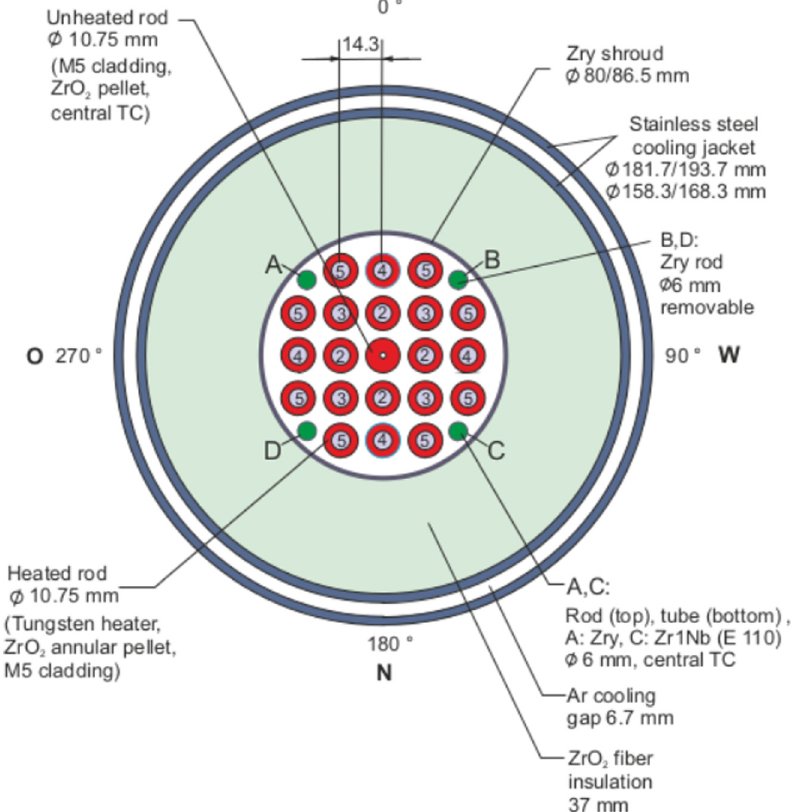
Fig. 4. Fuel rod simulation bundle – cross section [2].